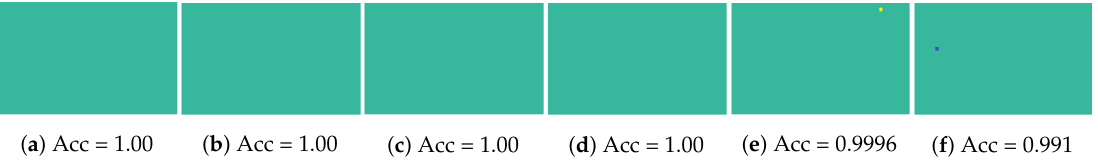
Figure 12. Classification results for the poultry minced meat class. Spots in poultry minced meat class represent the spectral misclassifications of Bovine and Ovine minced meat classes and Acc represents the accuracy of the poultry class for each